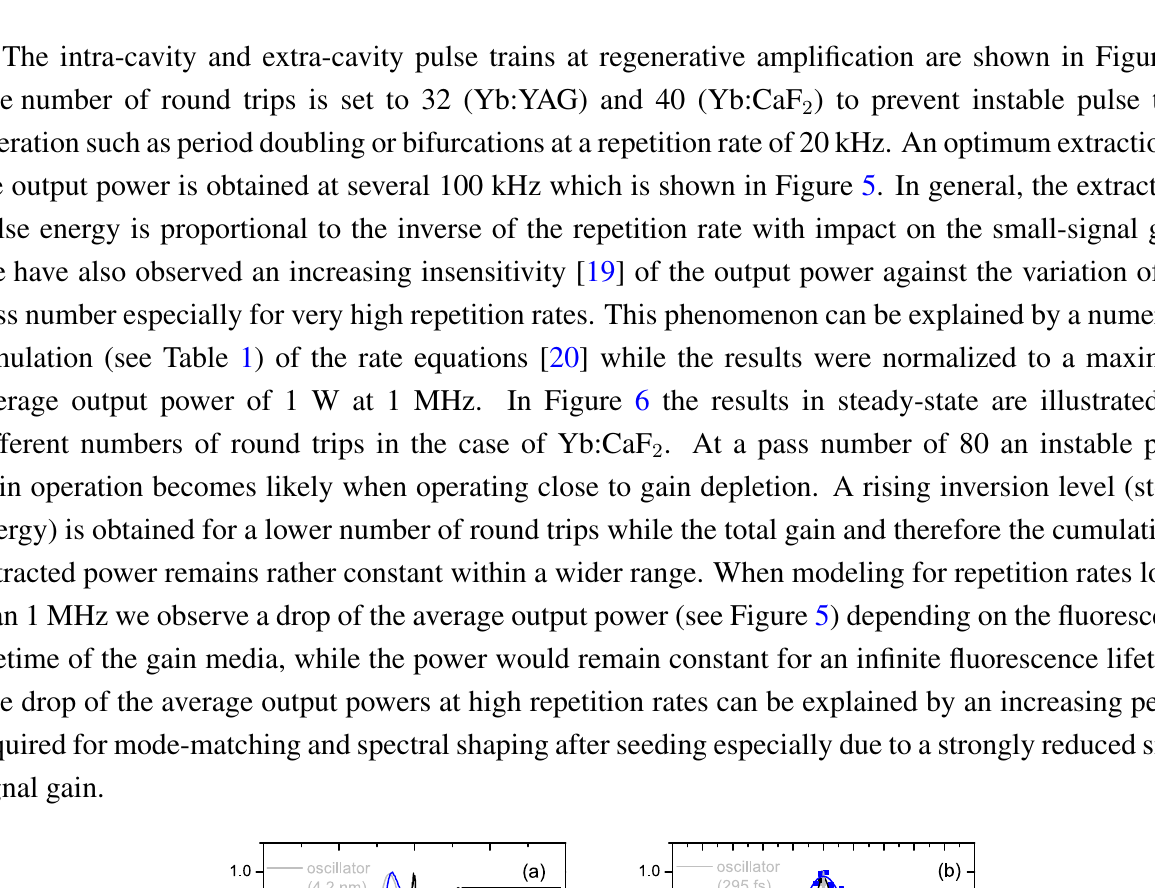
(blue) amplifier, inset: spectra for 2